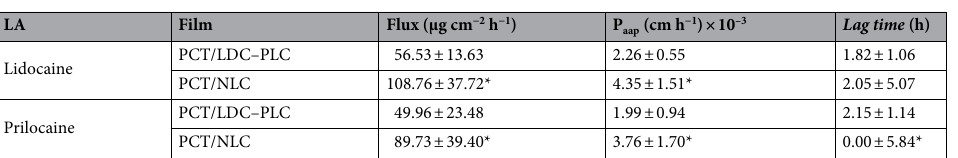
Table 2. LDC–PLC permeation tests from films through porcine buccal mucosa. Steady-state flux (µg cm −2 h −1 ), apparent permeability coefficient (P aap ; cm.h -1 × 10 –3 ) and lag time (h) were quantified by HPLC. Data are mean (± SD), n = 6 (p < 0.05, t test). Each parameter was evaluated separately for each anesthetic. t test. *Indicate significant statistical difference (p < 0.05) between control and hybrid batches.